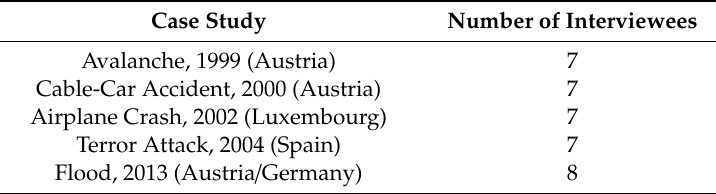
Table 1. Overview of number of interviewees per case